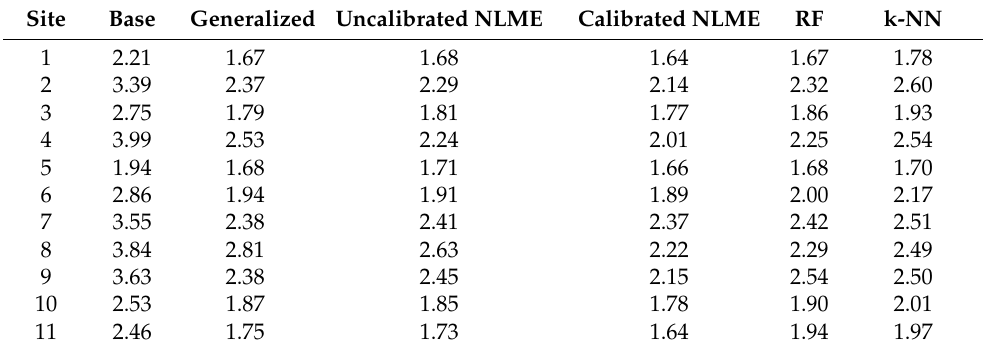
Table 4. The root mean square error (RMSE, in cm) of the six methods across the 11